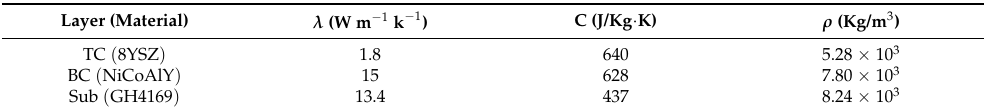
Figure 2. Temperature-dependent material properties [27]: ( a ) variation in Young’s modulus with temperature, ( b ) variation in Poisson’s ratio with temperature, ( c ) variation in coefficient of thermal expansion with temperature. Table 1. Thermal conductivity ( λ ), specific heat capacity (C), and density ( ρ ) of TC layer, BC layer, and Sub layer at 20 °C [27] .